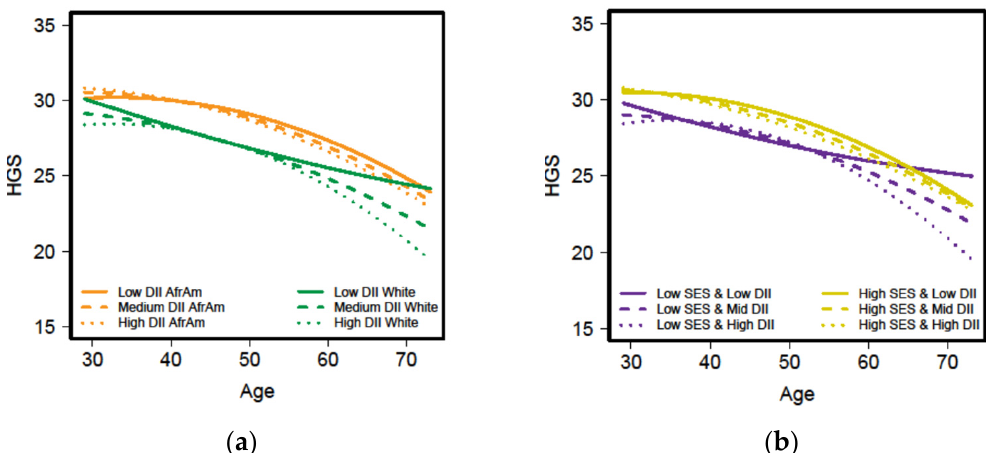
Figure 2. Handgrip strength (HGS) by age for HANDLS women across three levels of the dietary inflammatory index (DII) and either race (( a ) African American (AfrAM) and White) or socioeconomic status (( b ) SES). HANDLS-Healthy Aging in Neighborhoods of Diversity across the Life Span.